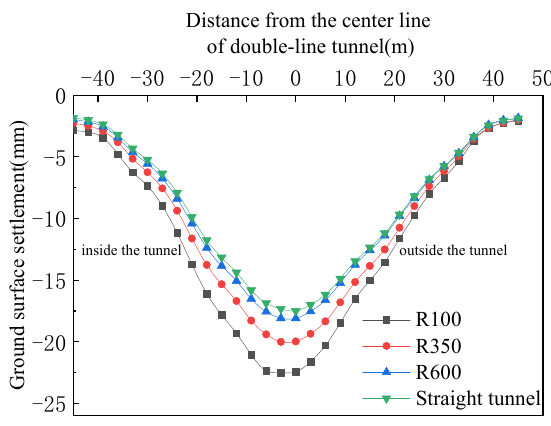
Figure 7. Settlement curve of surface soil after double-track tunnel